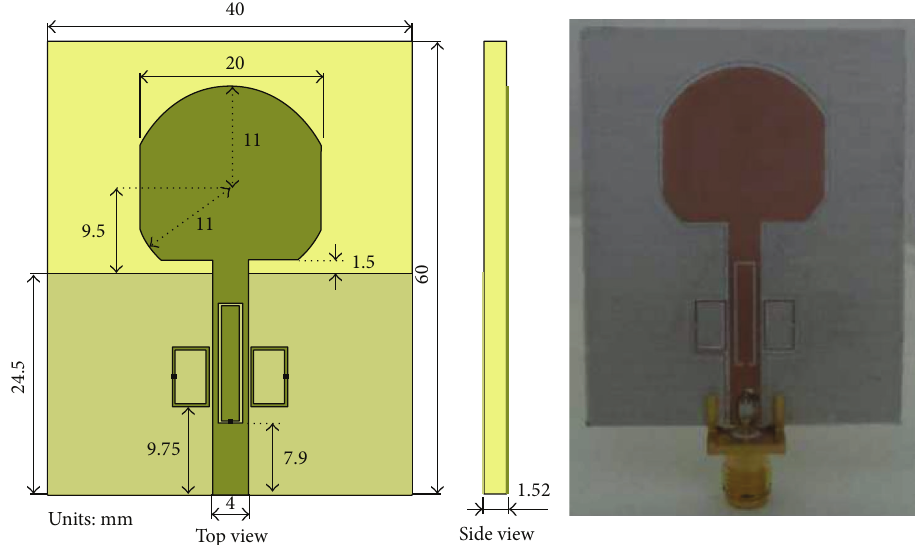
Figure 6: Geometry and photo of a filter antenna with two reconfigurable band notches [62].